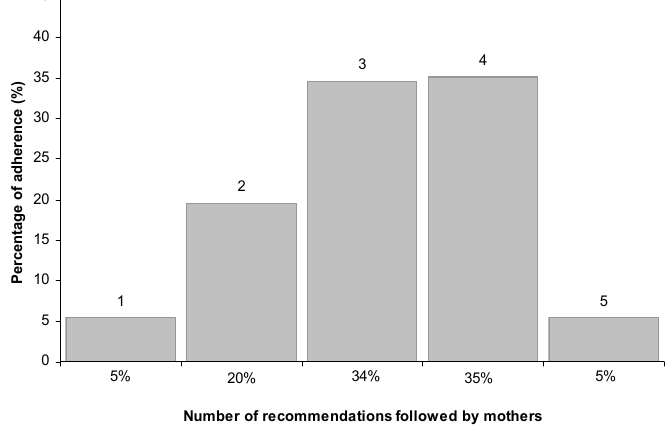
Figure 3. Number of recommendations (0, 1, 2, 3, 4 and 5) followed by mothers and percentage of compliance.